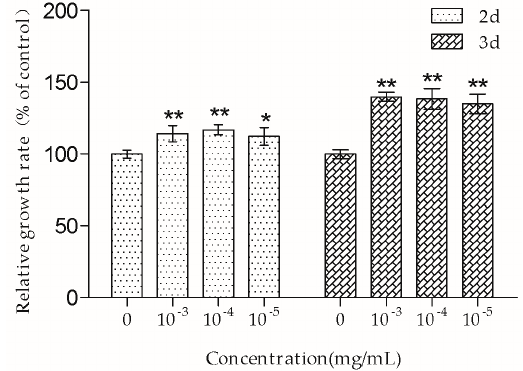
Figure 2. TSG promoted MC3T3-E1 cell proliferation. Data are represented as the mean ± SD of four determinations. * p < 0.05 and ** p < 0.01 when compared with the control group. Next, we measured TSG’s effect on MC3T3-E1 cell cycle progression. After being treated with TSG for one day, the cells were stained by PI and tested by flow cytometry. As shown in Figure 3a,b, TSG (10 − 3 , 10 − 4 , and 10 − 5 mg/mL) increased the percentage of cells in the S phase and decreased the percentage of cells in the G1 phase, indicating that cell DNA synthesis was promoted by TSG.